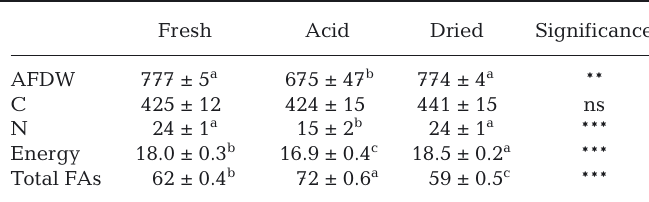
Table 1. Composition of the experimental diets, i.e. fresh salmon feces and salmon feces preserved by acidification (formic acid, pH <4) or